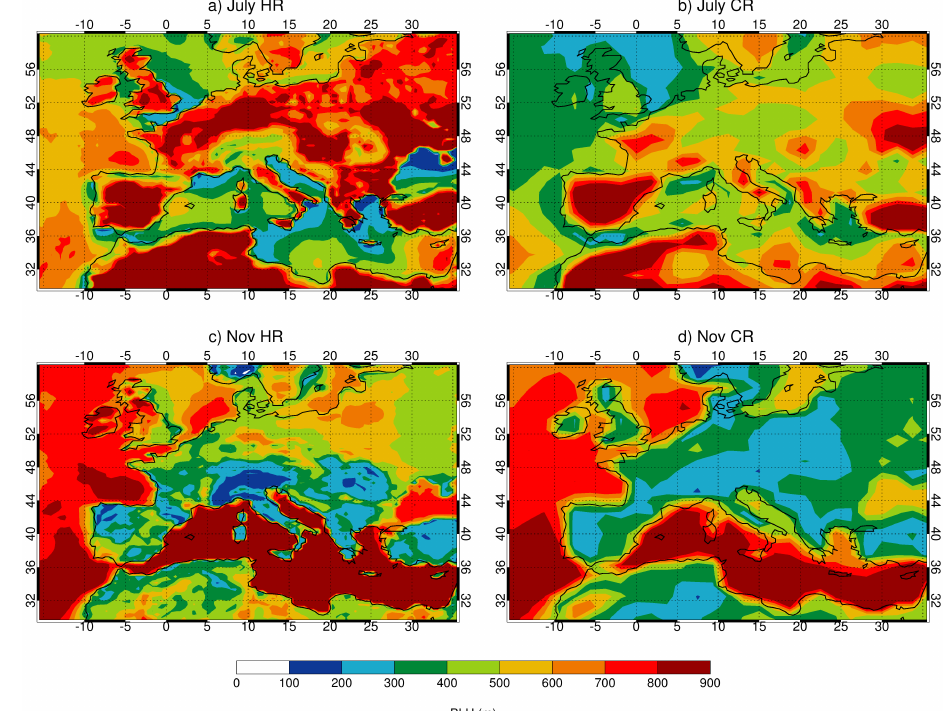
Fig. 7. Monthly mean boundary layer height.